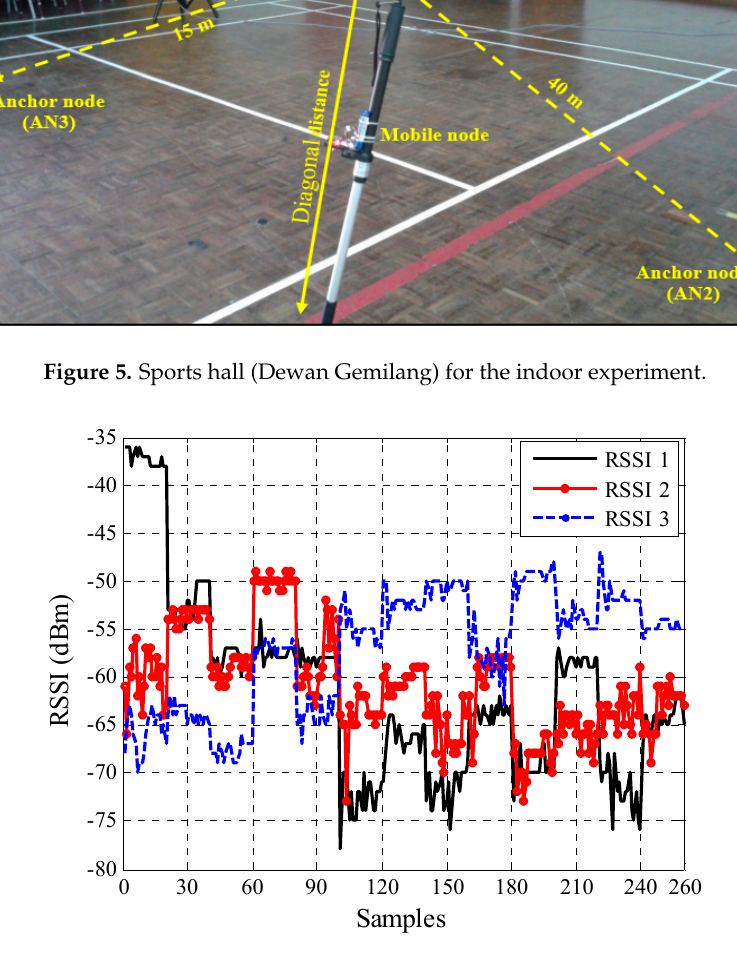
Figure 6. Measured RSSI values at the mobile node for the three anchor nodes with respect to a number of samples for each anchor node (260 samples) in the indoor velodrome.